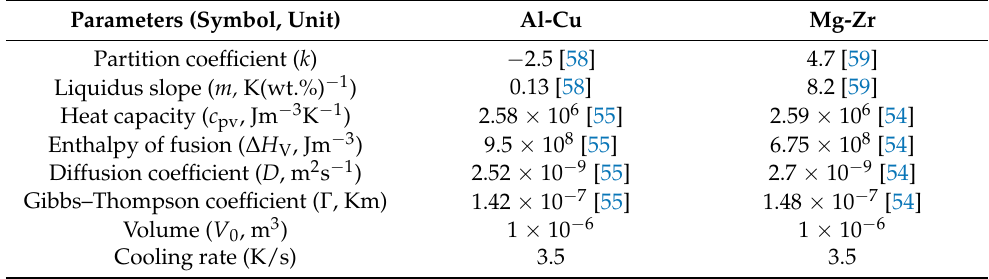
Table 1. The parameters used in the numerical calculations. Data from Refs. [54,55,58,59]. Parameters (Symbol,